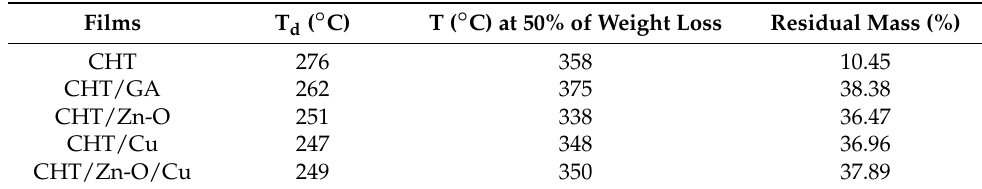
Table 2. Decomposition temperatures and weight loss and residual mass at 700 ◦ C of CHT